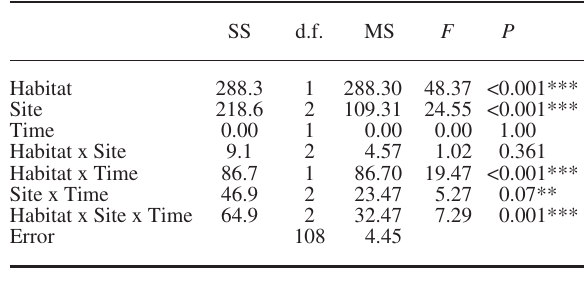
Table 1. – Results of 3-way ANOVA (n= 10; untransformed data) testing for differences in the number of taxa between habitats, times and sites. Significant differences are indicated: * p < 0.05, ** p < 0.01, ***p < 0.001.